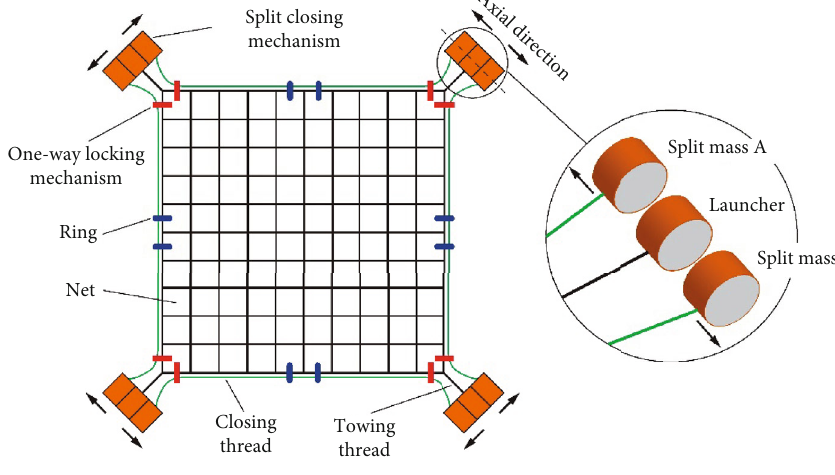
Figure 1: Split closing